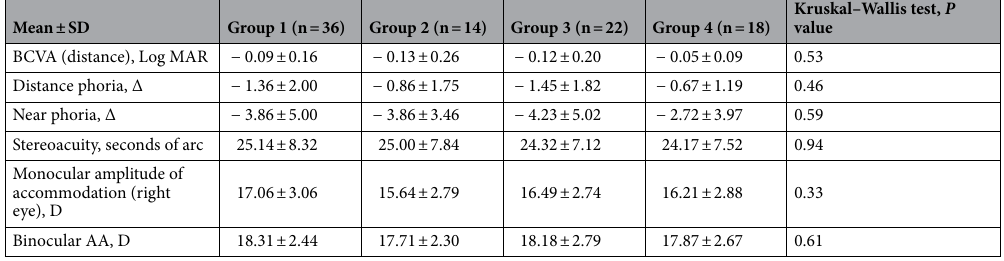
Table 3. Post-trial visual functions.